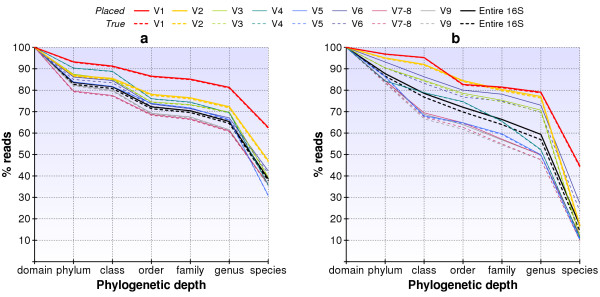
Simulated read resolution for targeted variable regions in diverse and representative samples. Simulation results are presented for (a) a diverse set of 387 bacteria and (b) 330 species representative of our samples. Simulated reads had lengths of 100 ± 20 bp and a 1% sequencing error rate. Solid lines show assignments made by our methodology, while dashed lines show the proportion that are correctly assigned.